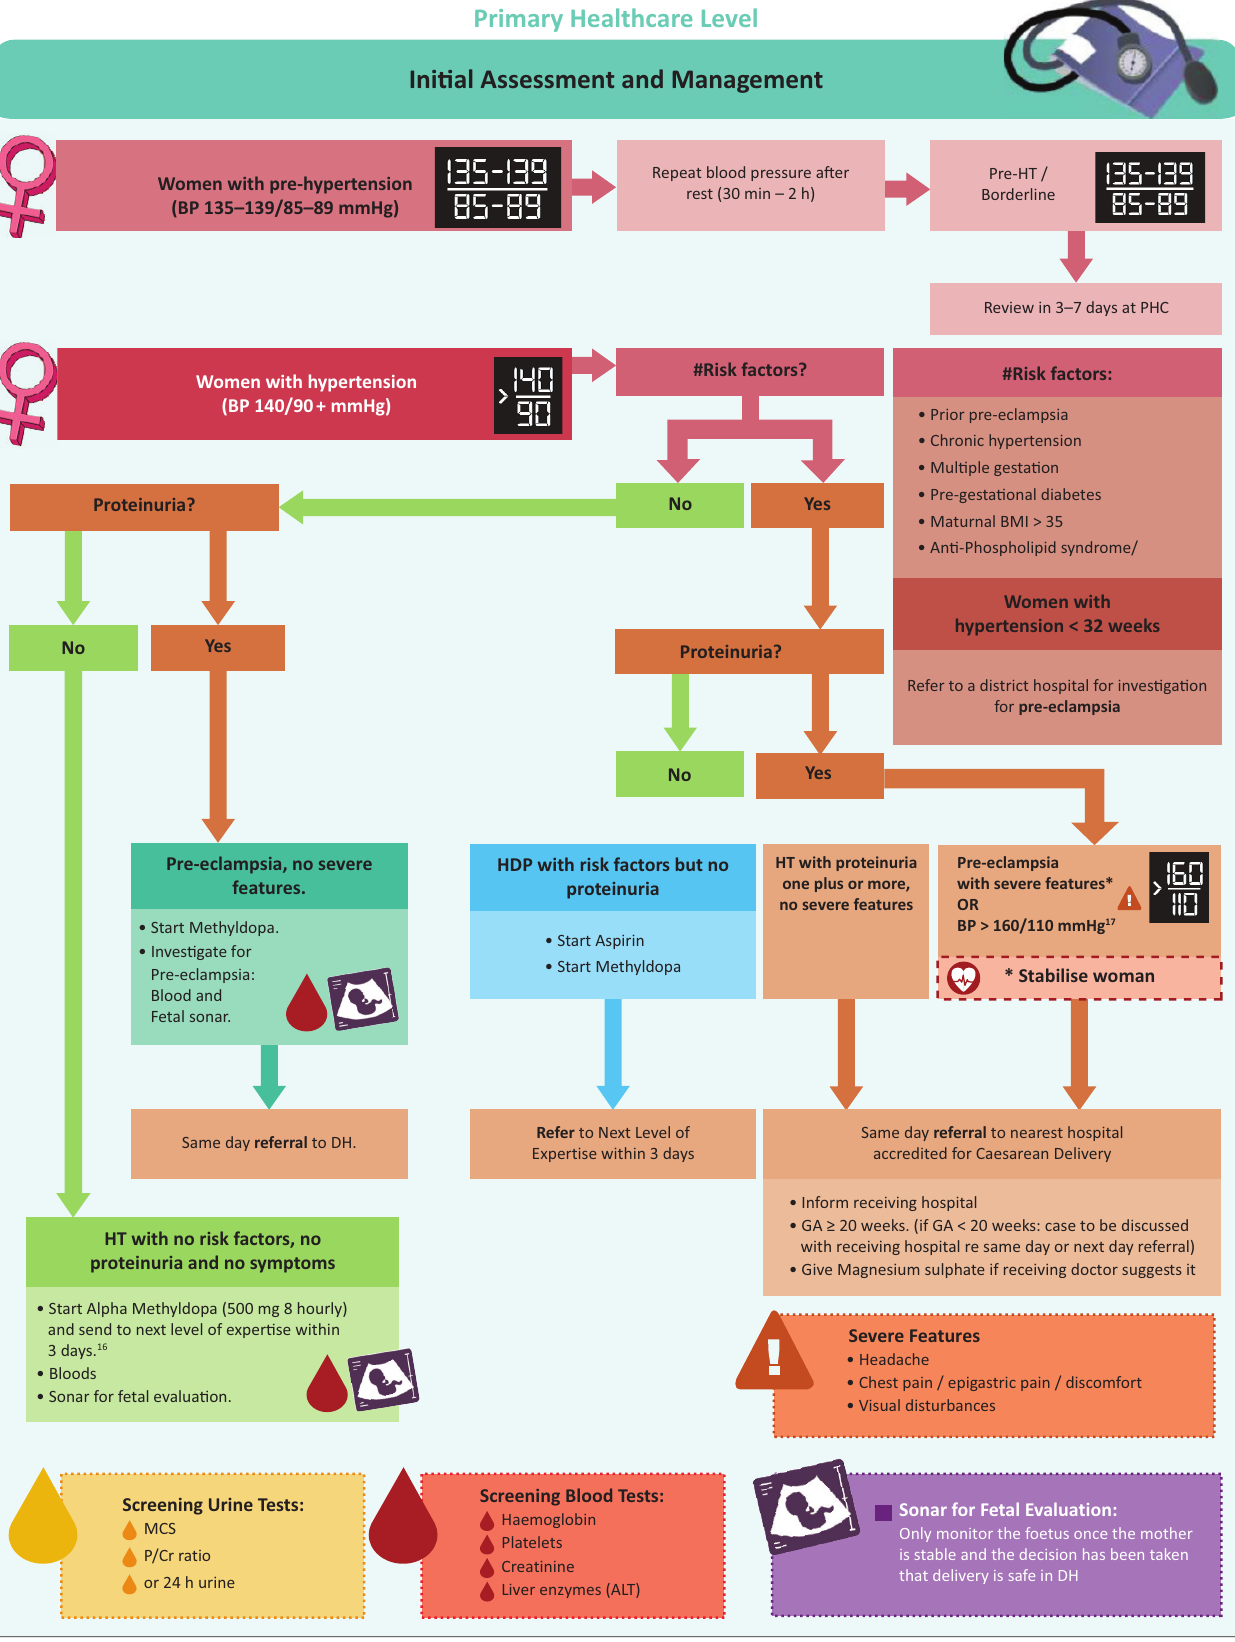
Refer to a district hospital for inves ga on for